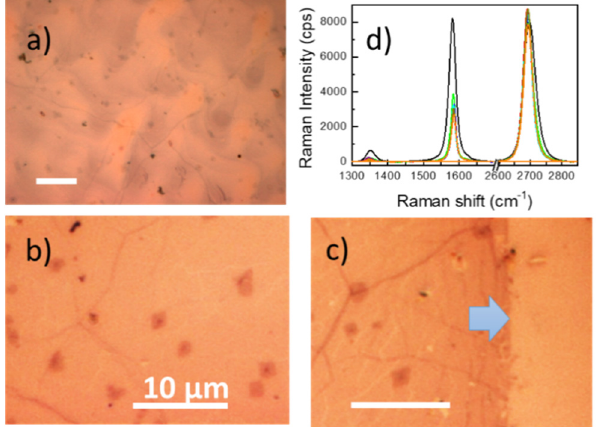
Figure 3. Optical images of an alumina supported membrane ( h ≈ 100 nm) ( a ) with graphene/PMMA, ( b ) with graphene once PMMA is eliminated showing the wrinkles and bi/tri-layer graphene spots and ( c ) graphene edge (indicated by a blue arrow). ( d ) Raman spectra of graphene at different positions. Black curve corresponds to a graphene bilayer (darker spot in the images). The scale bar corresponds to 10 µm in all cases.